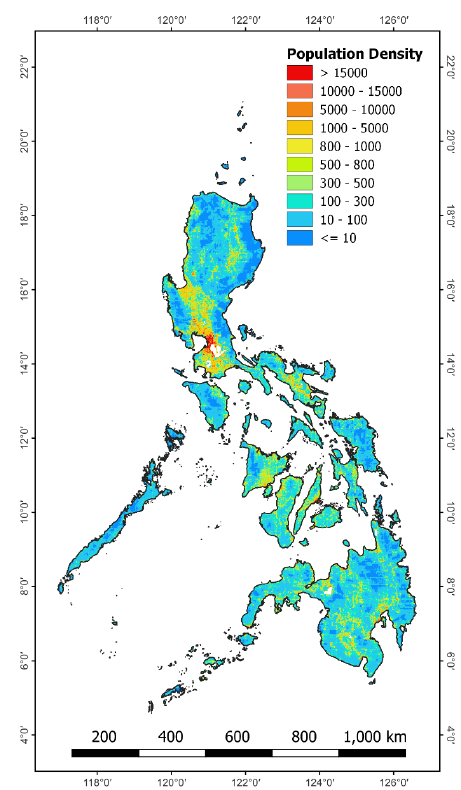
Figure 7. Spatial distribution of people in2020 based on the population density data from WorldPop. The population in metropolitan areas is denser than in rural areas.